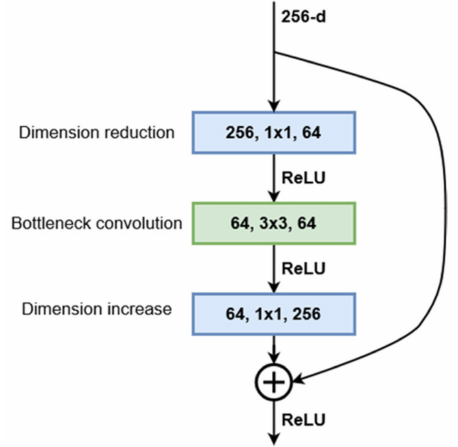
Figure 1. Structure of residual bottleneck building